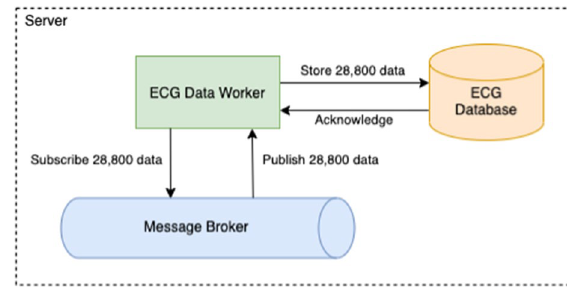
Fig. 6 Database write evaluation